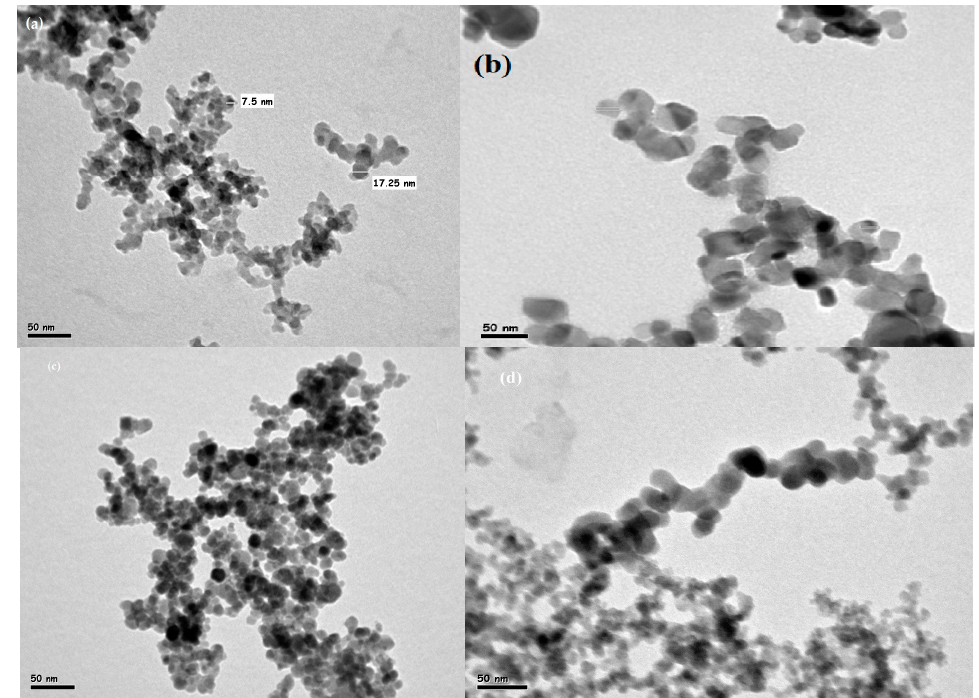
Figure 2. TEM micrographs of ( a ) silica; ( b ) silica PAMPS-Na; ( c ) silica PAMPS-Na/AAm; and ( d ) PAAm nanogels.